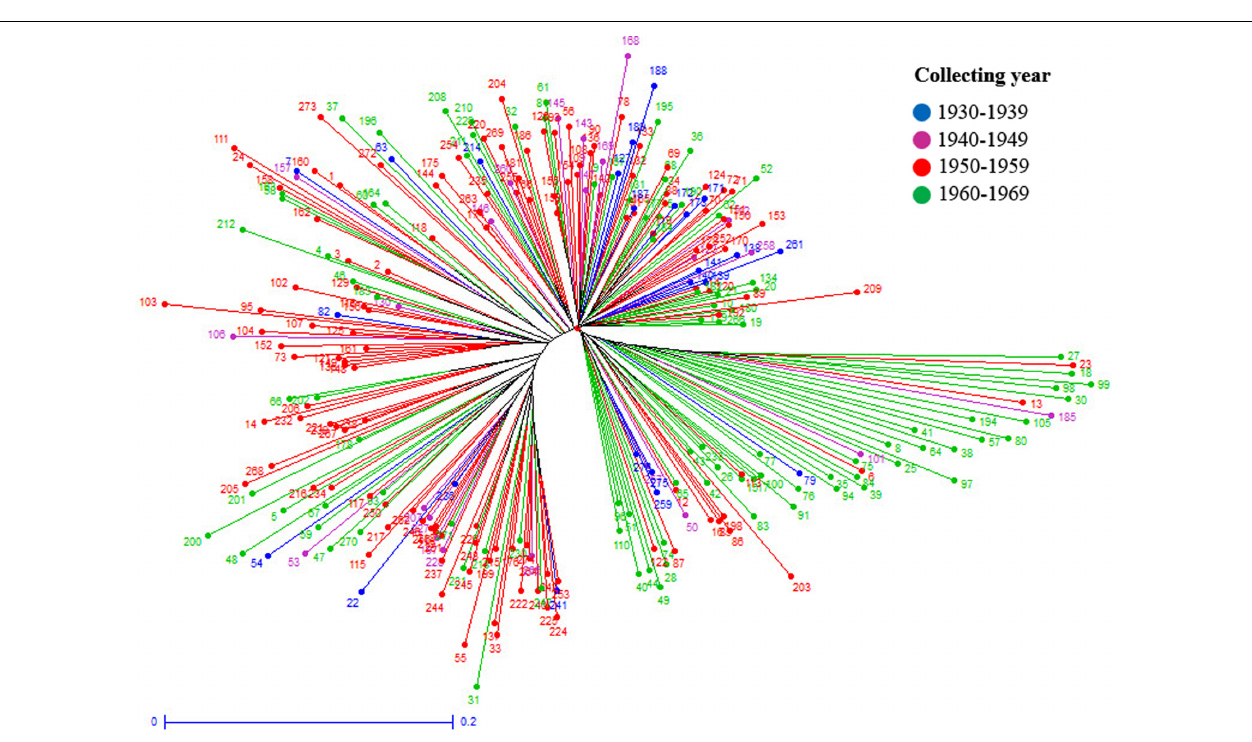
FIGURE 11 | A weighted neighbor-joining clustering dendrogram generated using 16506 SNPs and 270 Iranian hexaploid wheat landraces to show the years of accessions collected.